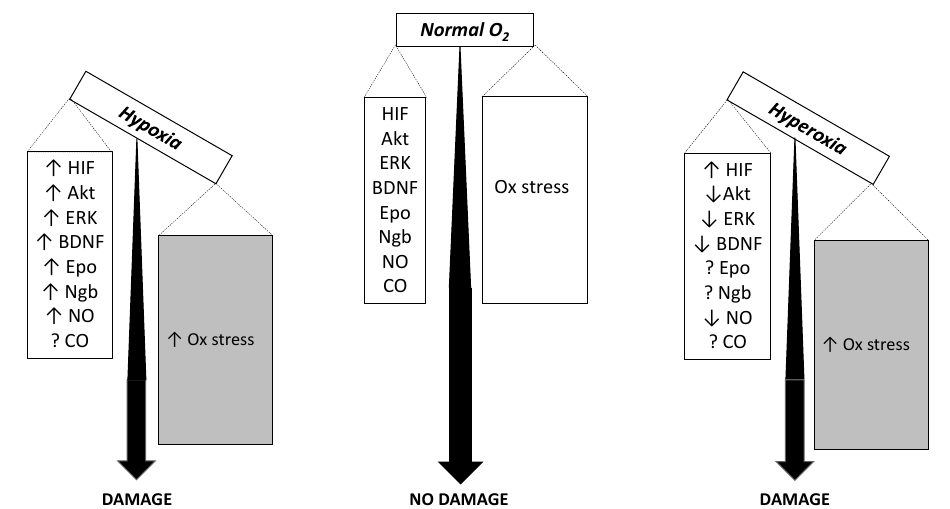
Figure 2. Balance between harmful oxidative stress (Ox stress, right box) and protective antioxidant defense (left box). With respect to a normoxic condition, moderate chronic hypoxia increases oxidative stress to a greater extent than moderate chronic hyperoxia, as indicated by different grey intensities. But it also increases the protective antioxidant defense to a greater extent than moderate hyperoxia (see the behavior of the various markers). The overall result is that both hypoxia and hyperoxia lead to an imbalance of the equilibrium between reactive O 2 species (ROS) generation and the anti-ROS defense, which finally cause neuronal apoptosis and damage. Downward arrows, upward arrows and question marks mean decrease, increase and unclear effect, respectively.